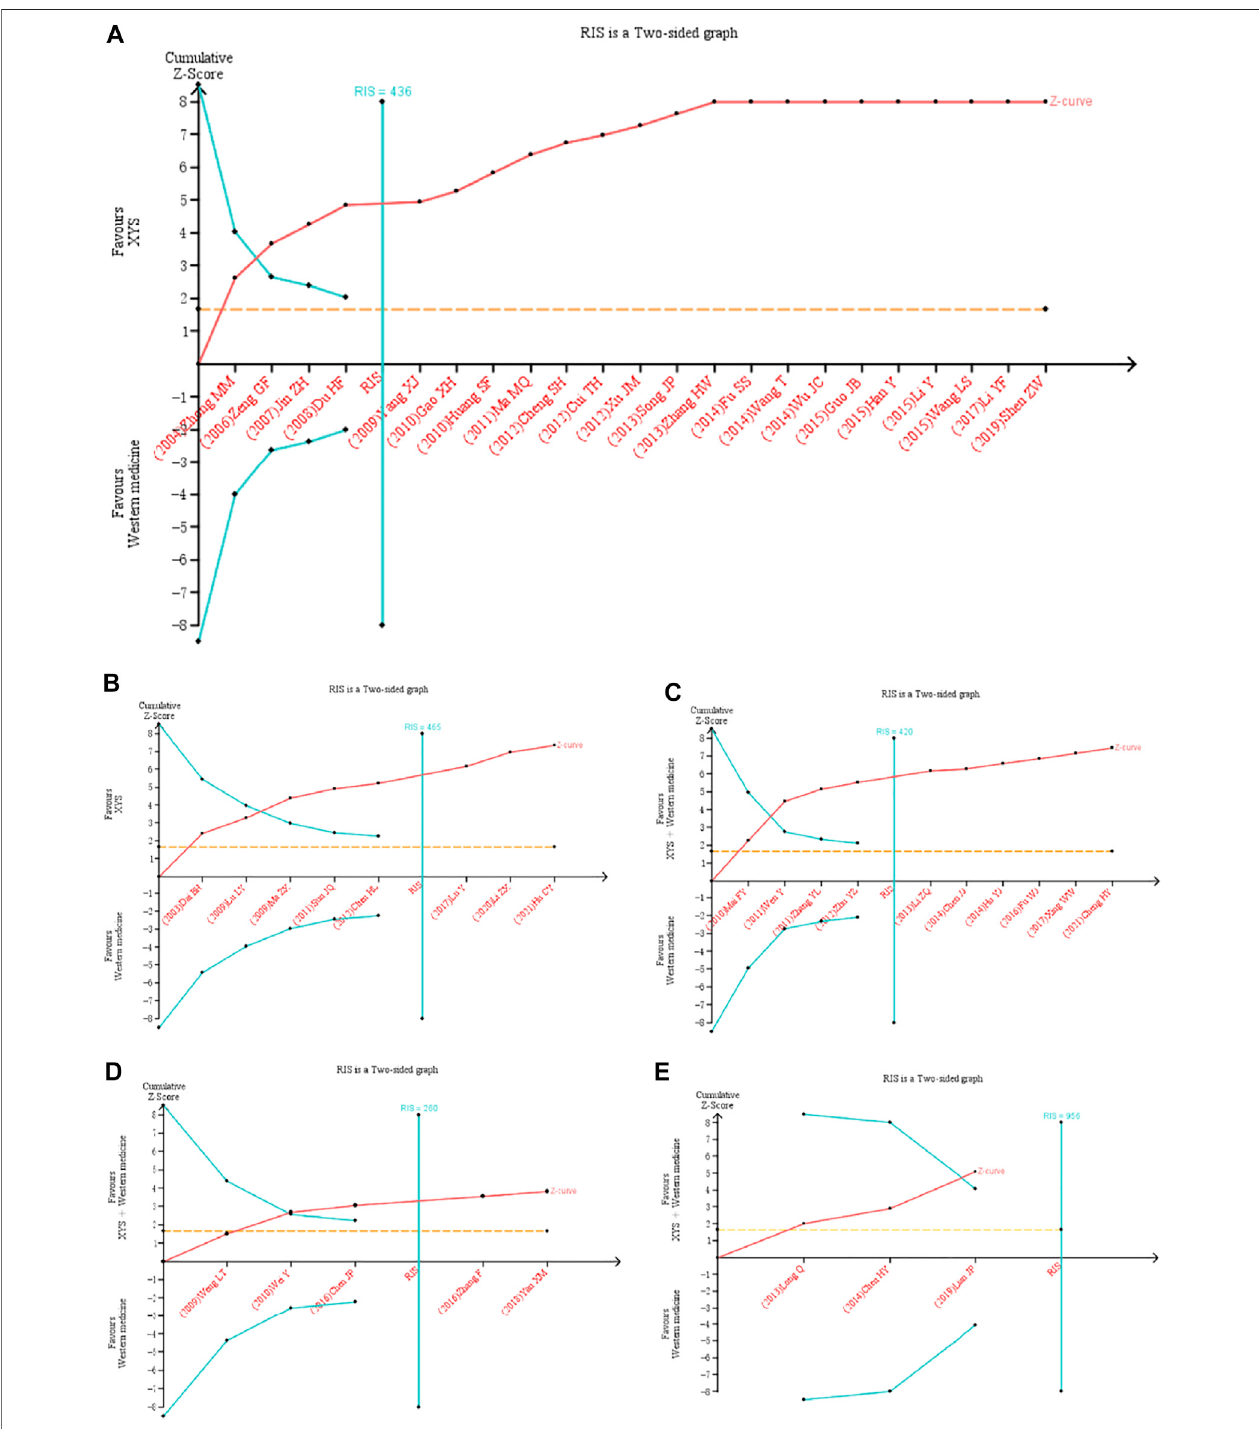
FIGURE8 | Trialsequentialanalysisfor the effective rate in allincludedtrials. TSAof XYSin treatment ofFGIDs. (A) XYS asan adjuvant towestern medicine for FD. (B) XYS as an adjuvant to western medicine for IBS. (C) XYS combined with western medicine as an adjuvant to western medicine for FD. (D) XYS combined with western medicine as an adjuvant to western medicine for IBS. (E) XYS combined with western medicine as an adjuvant to western medicine for FC. As shown in fi gure (A) – (D) , the cumulative z-value crossed the TSAthreshold, indicating that XYSwas effectivein treatingFD and IBS. The cumulative Z value reached TIS, indicating that the sample size of the current study has reached the expected sample size. As shown in fi gure (E) , The cumulative Z-value did not reach TIS, but crossed the boundary value of TSA. Although XYS combined with Western medicine did not reach the expected sample size in the treatment of FC, the clinical ef fi cacy has been con fi rmed. RIS, required information